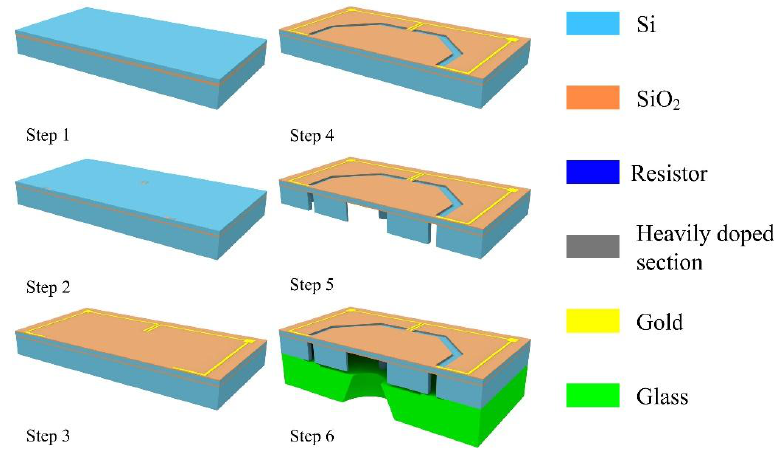
Figure A1. Main fabrication process of sensing chip.